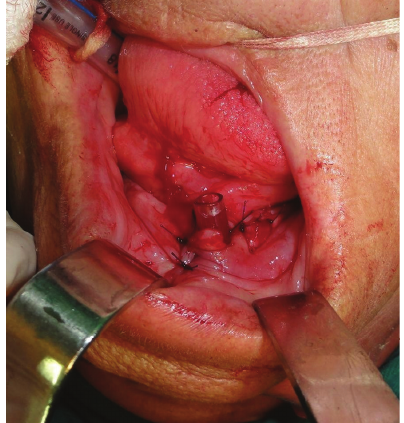
Figure 2: Installation of a Pen Rose irrigation